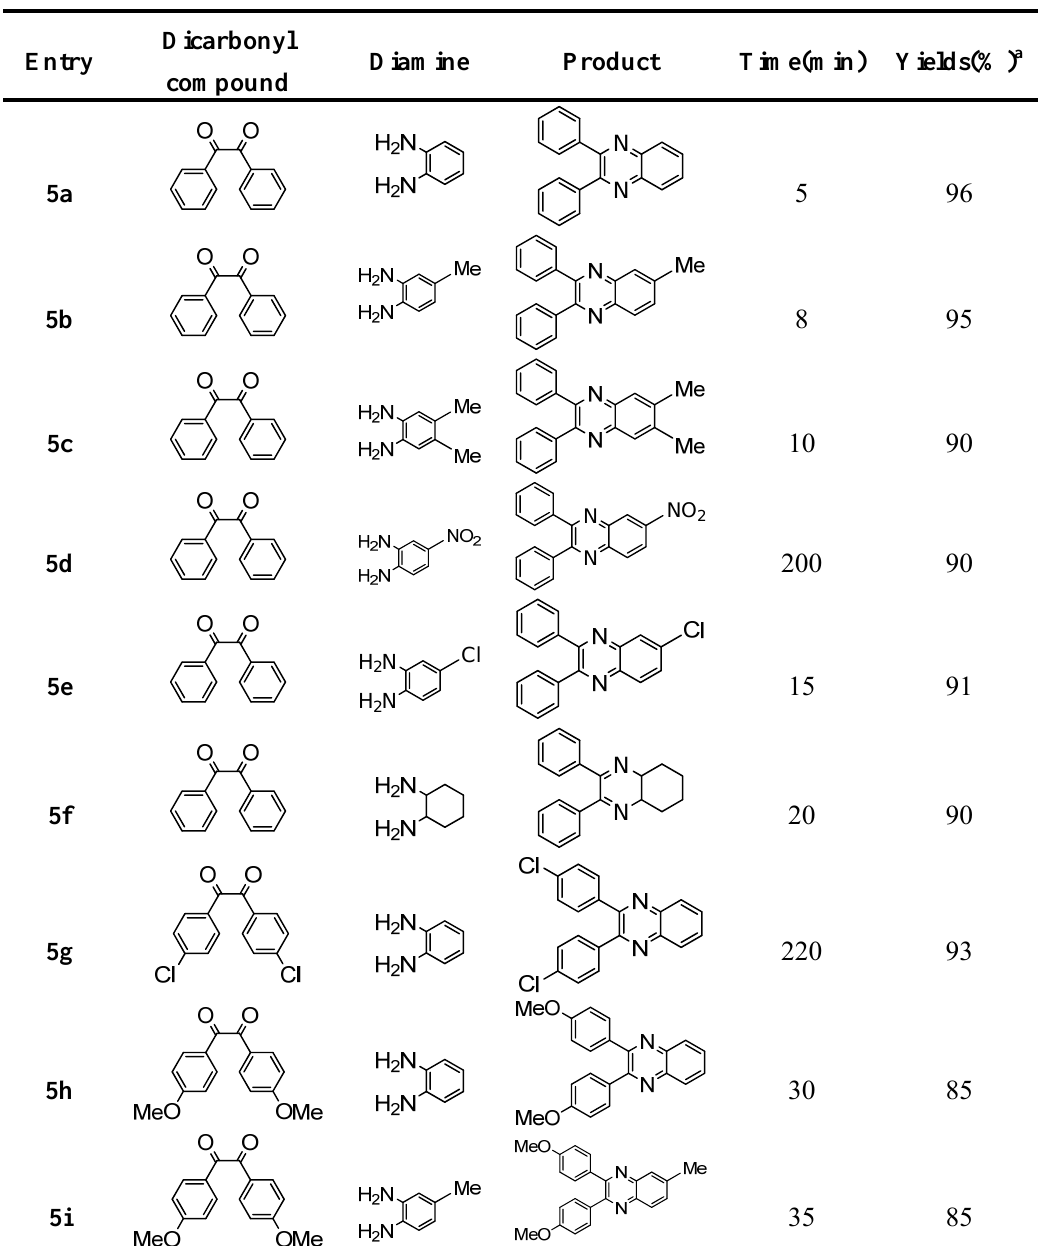
Table 2 . Synthesis of quinoxaline derivatives catalyzed by SBSSA at room